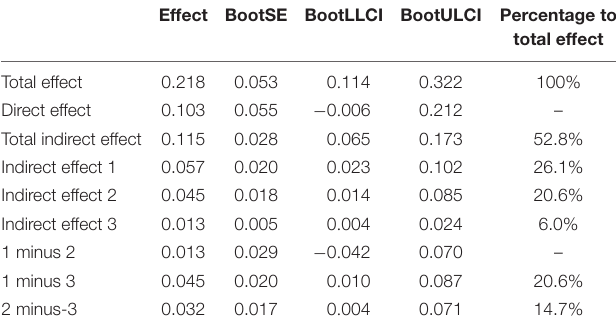
TABLE 4 | The mediating effect of victim sensitivity on knowledge hiding.